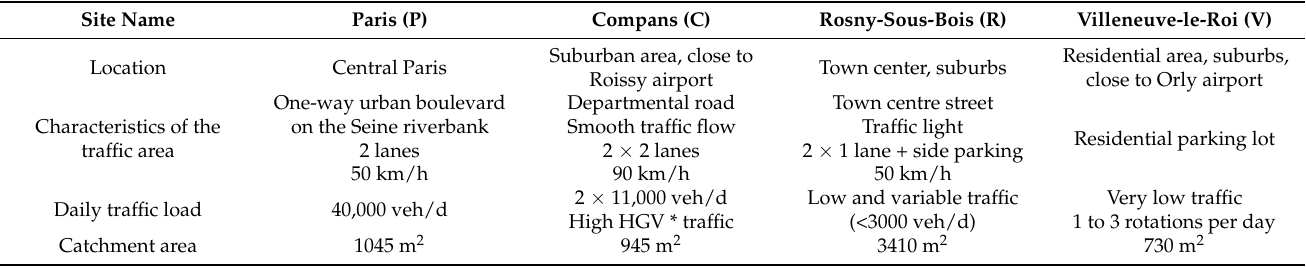
Table 1. Sampling sites